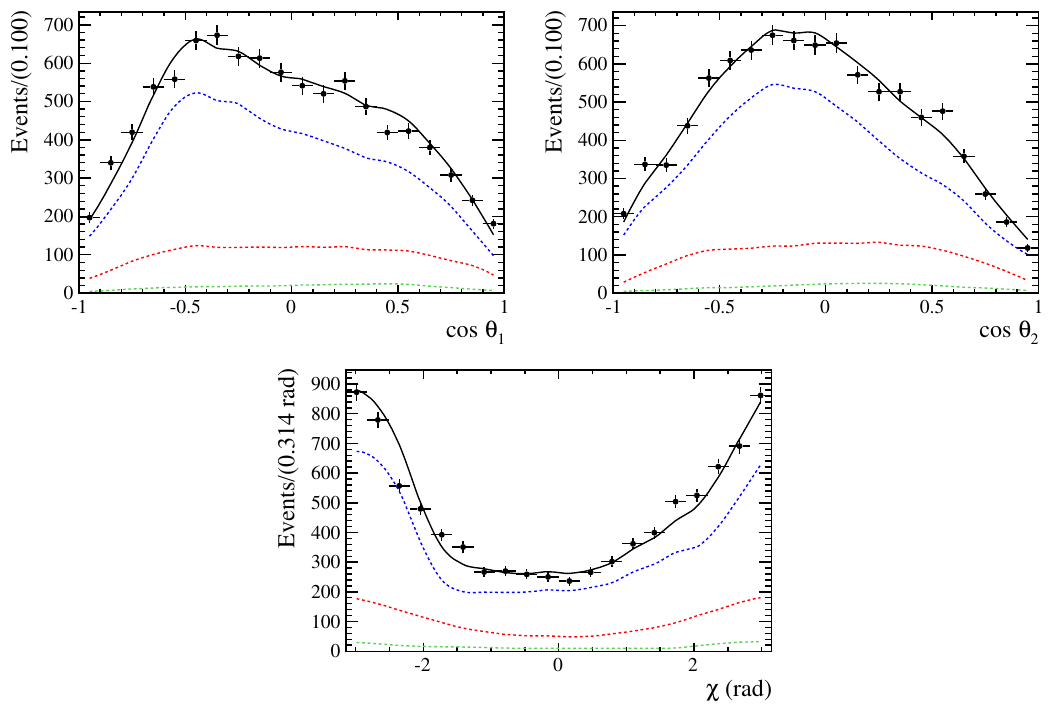
Figure 7 . Angular projections of the D 0 ! (cid:25) + (cid:25) (cid:0) (cid:25) + (cid:25) (cid:0) (cid:12)t results (black solid line) in the transver- sity basis. The signal component is shown in blue (dashed), the background component in red (dashed) and the wrongly tagged contribution in green